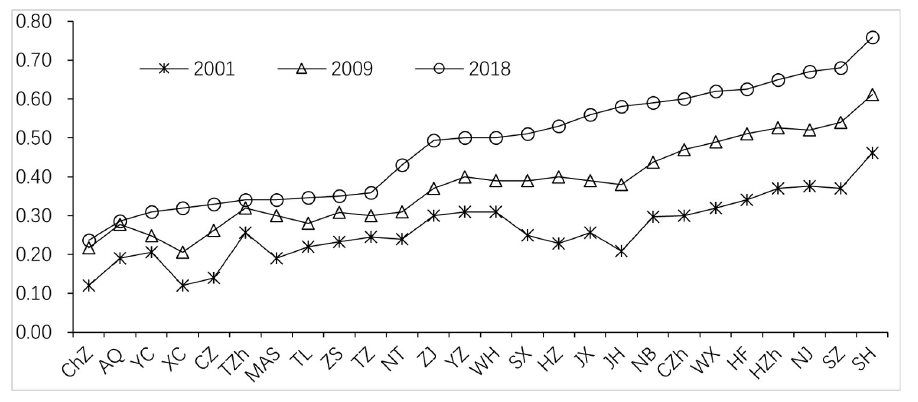
Fig 1. Level of HDCT of 26